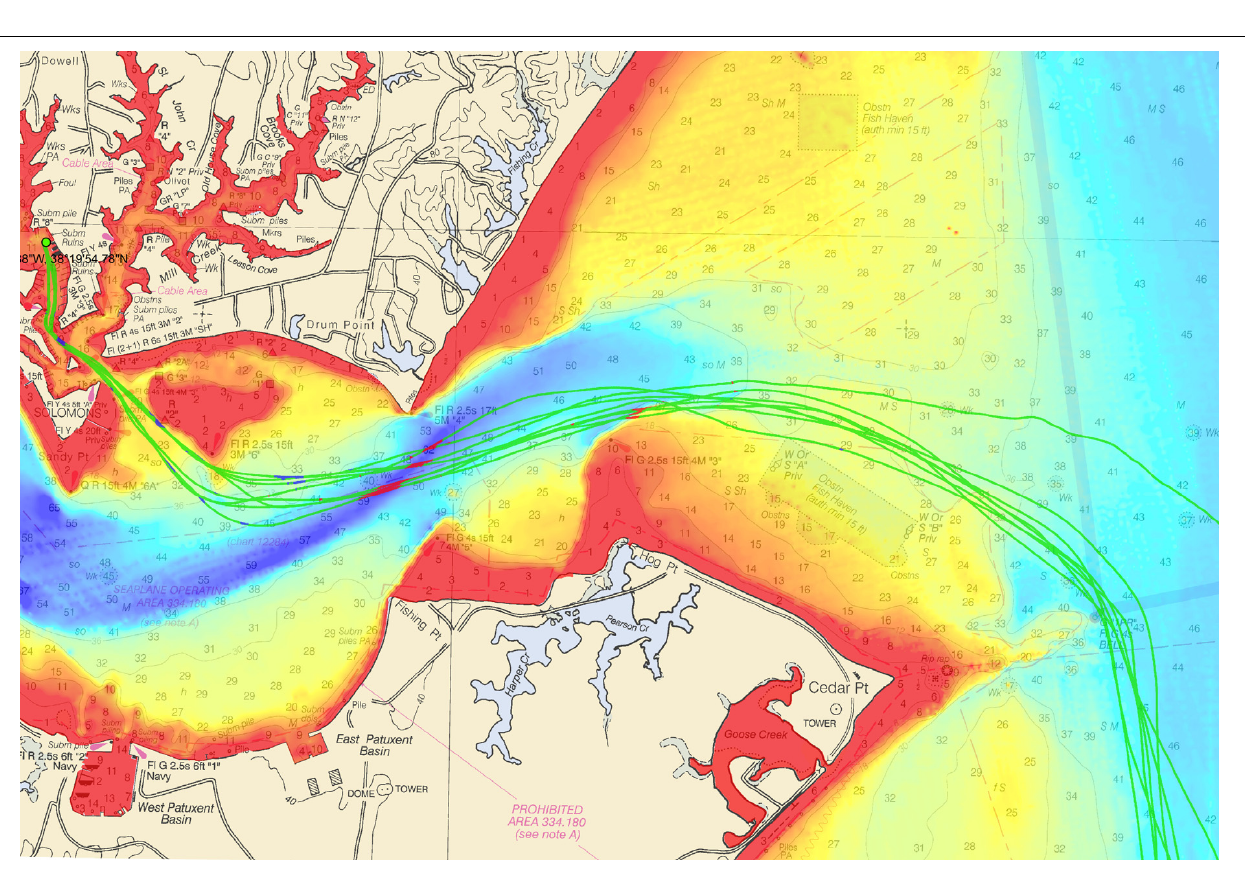
Frontiers in Marine Science |